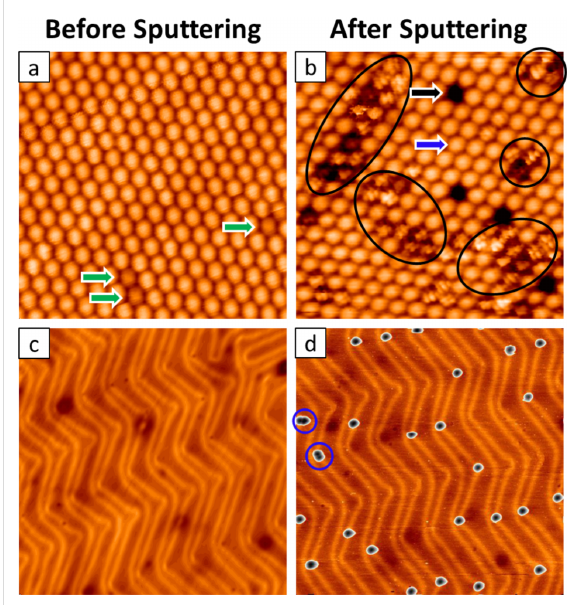
Figure 2: (a) (14 × 14 nm 2 ) STM image ( U b = − 2.5 V, I s = 0.3 nA) of a fullerene island before Ar + bombardment. (b) (14 × 14 nm 2 ) STM image ( U b = 0.6 V, I s = 0.3 nA) of the fullerene island after Ar + bombardment. The blue arrow indicates a pristine C 60 molecule. The black arrow points to a vacancy inside the island. Black circles mark regions with modified molecules. (c) (65 × 65 nm 2 ) STM image ( U b = 1.8 V, I s = 0.3 nA) of the herringbone reconstruction before Ar + bombardment. (d) (65 × 65 nm 2 ) STM image ( U b = 0.5 V, I s = 0.09 nA) of single molecules attached to the herringbone elbow sites. Two dimers are enclosed by blue